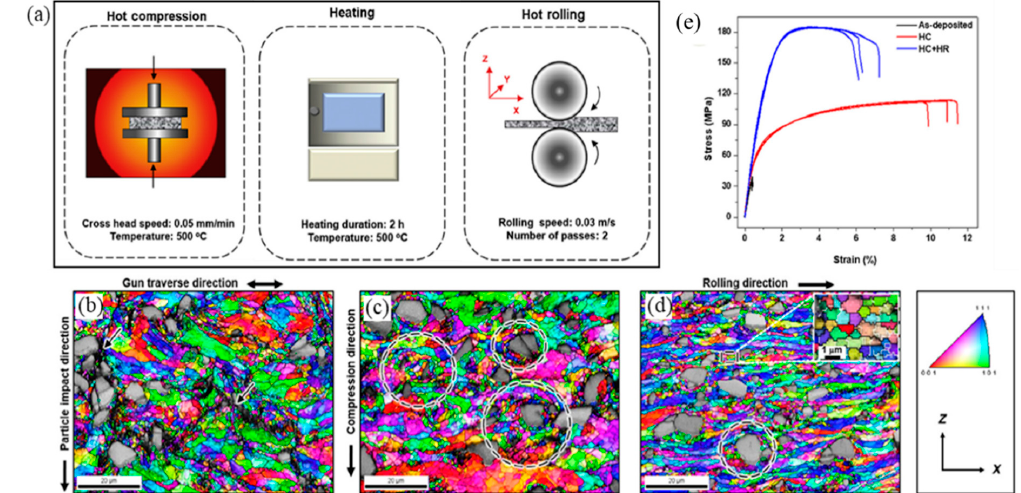
Figure 21. ( a ) Schematic illustrations of a hybrid post hot compression + hot rolling treatment, ( b – d )